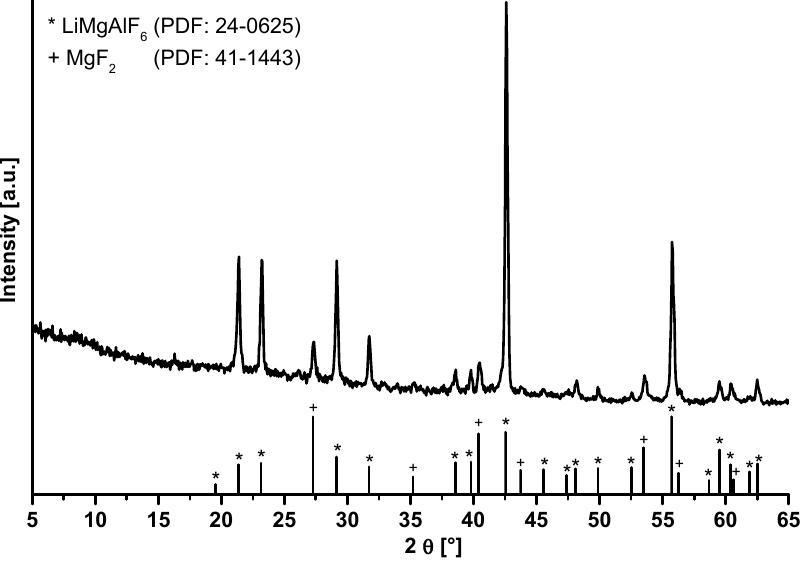
Figure 12. Comparison of powder X-ray patterns of LiMgAlF 6 xerogel in an open crucible at 500 ° C for a one hour calcination time in a non-preheated oven with crystalline LiMgAlF 6 phase (PDF: 24-0625) and MgF 2 phase (PDF: 41-1443).